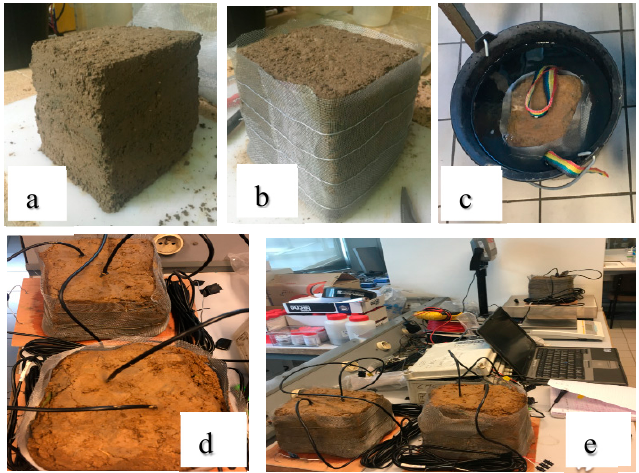
Figure 3. Undisturbed sample calibration method: ( a ) undisturbed block; ( b ) block packed with a metallic grid; ( c ) block put in water until saturation; ( d ) block allowed to dry in the open air; ( e ) taking measurements.